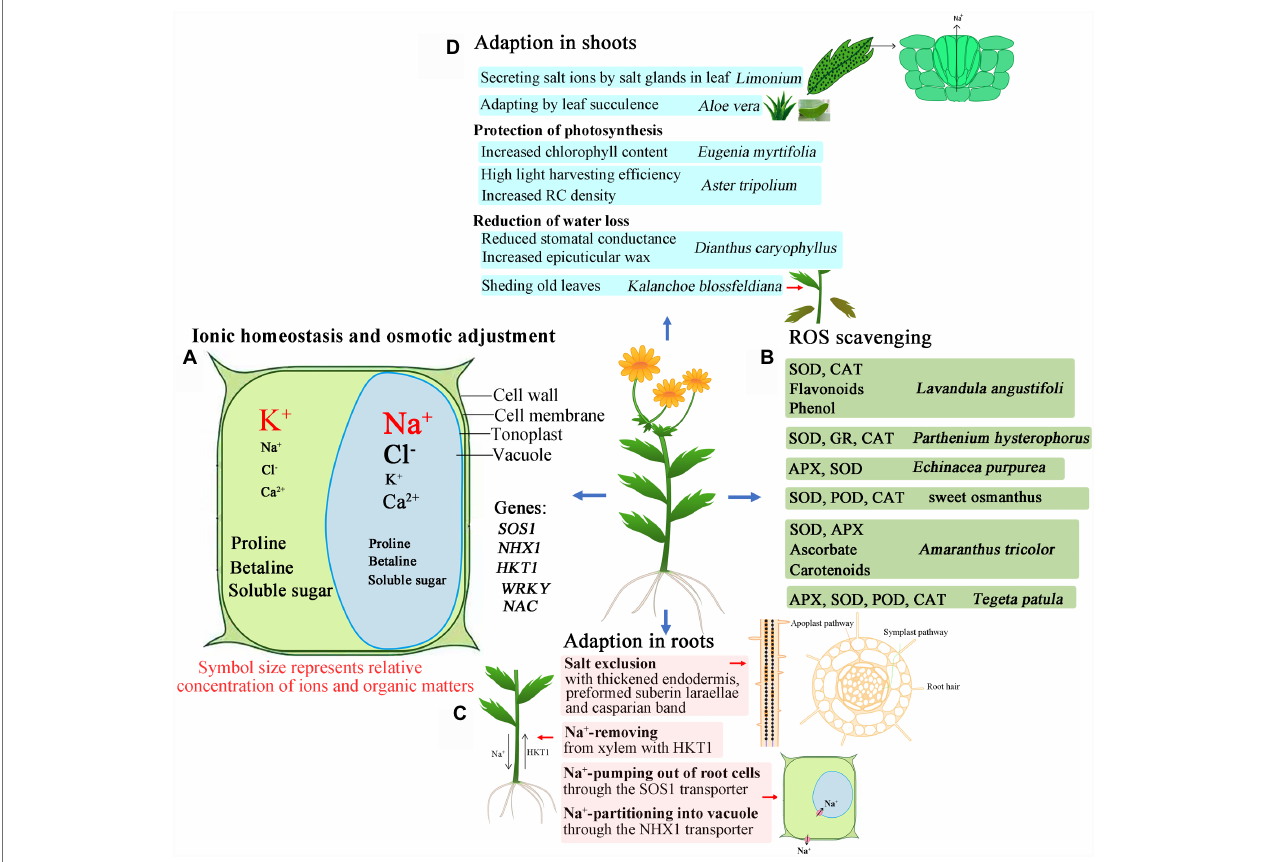
FIGURE 1 | Graphical summary of the adaptation of ornamental plants to salinized environments. (A) Adaption through ionic homeostasis and osmotic adjustment; (B) Adaption through ROS scavenging; (C) Adaption through salt exclusion, removing and pumping out of cells in roots; (D) Adaption through salt secretion, leaf succulence, photosynthesis protection, and reduction of water loss in shoots. SOS1 : Salt Overly Sensitive 1, e.g., CcSOS1 gene from Chrysanthemum crissum ; NHX1 : vacuolar Na + /H + antiporter, e.g., IbNHX2 gene from Ipomoea batatas ; HKT1 : high-affinity K + transporters, e.g., AlHKT2:1 gene from Aeluropus lagopoides ; WRKY: e.g., DgWRKY4 genes of from Dendronthema grandiform ; NAC : e.g., DgNAC1 gene from Dendronthema grandiform ; ROS: reactive oxygen species; SOD: superoxide dismutase; CAT: catalase; APX: ascorbate peroxidase; POD: peroxidase; GR: glutathione reductase; RC: reaction center. Symbol size represents relative content of ions and organic matter in plant